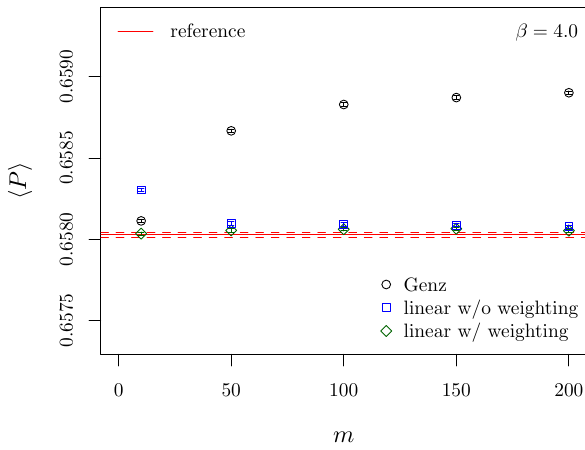
Fig. 3 Comparison of plaquette expectation values for Genz partition- ing G m and linear partitioning L m w/ and w/o weighting in 1 + 1 dimensions on a L 2 = 100 2 lattice for β = 4 . 0 as a function of